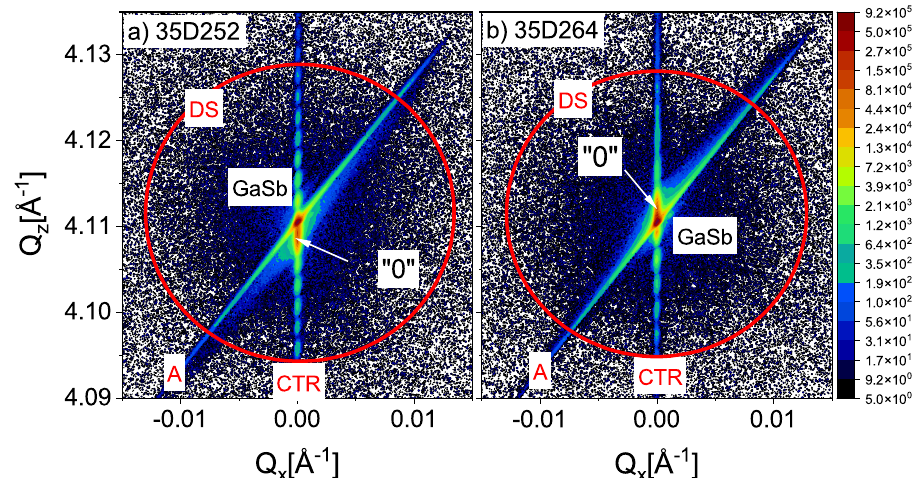
Figure 4. RMS maps for two InAs/AlSb T2SL with the smallest measured lattice mismatch: ( a ) 35D264 ( b ) 35D252. In both panels, crystal truncation rod, CTR; diffuse scattering, DS; red circles; A, analizer streak parallel to the diffracted beam.